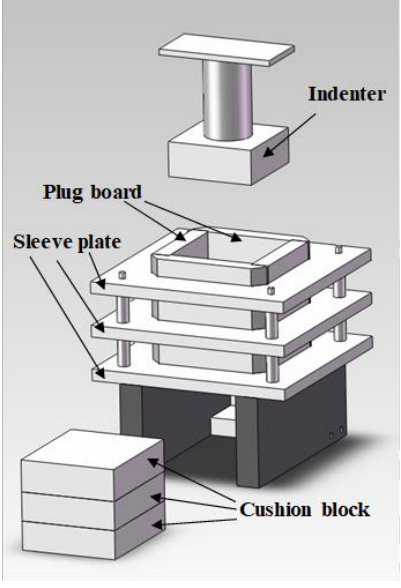
Figure 4. Mould schematic diagram for pressure forming method.